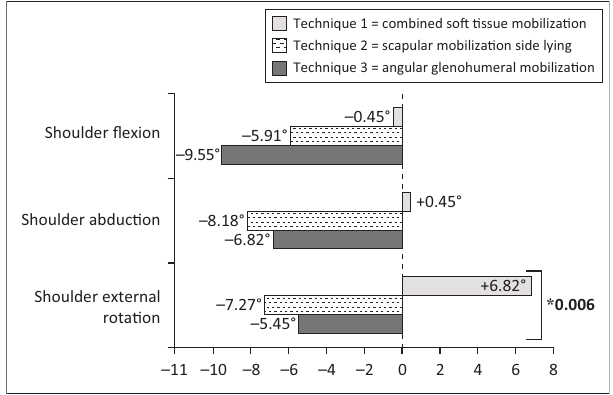
FIGURE 3: Average change in passive range of motion for the shoulder for each technique TABLE 3: Pairwise comparison of the change in PROM for external rotation. Variables p Technique 1 – Technique 2 Technique 3 – Technique 1 Technique 2 – Technique 3 1.000 PROM, passive range of motion. * , p < 0.05. TABLE 4: Pain experienced by the patients during mobilisation (visual analogue scale; median ± interquartile range). Variables